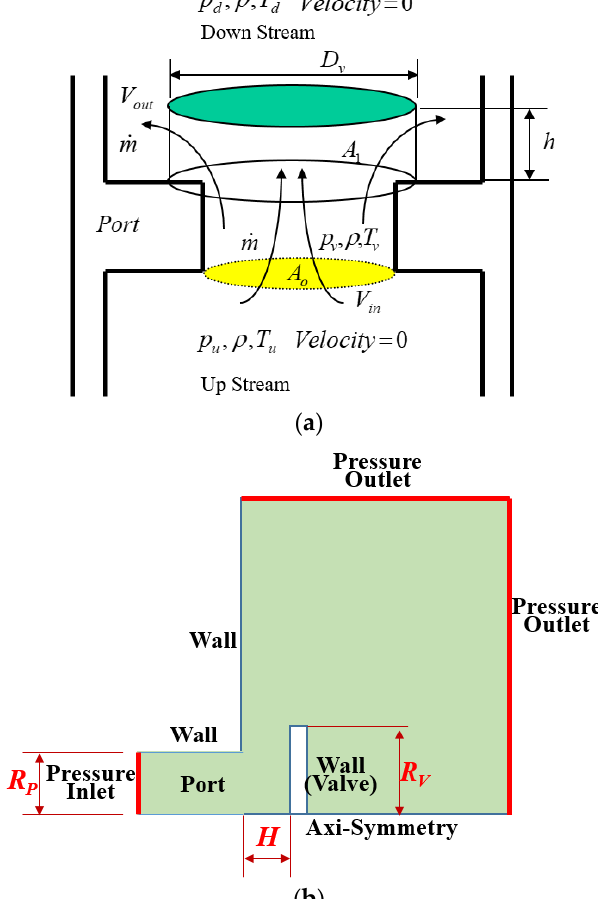
Figure 1. Analysis model and boundary conditions. ( a ) Schematic of refrigerant flow near valve; ( b ) Analysis domain and boundary conditions.